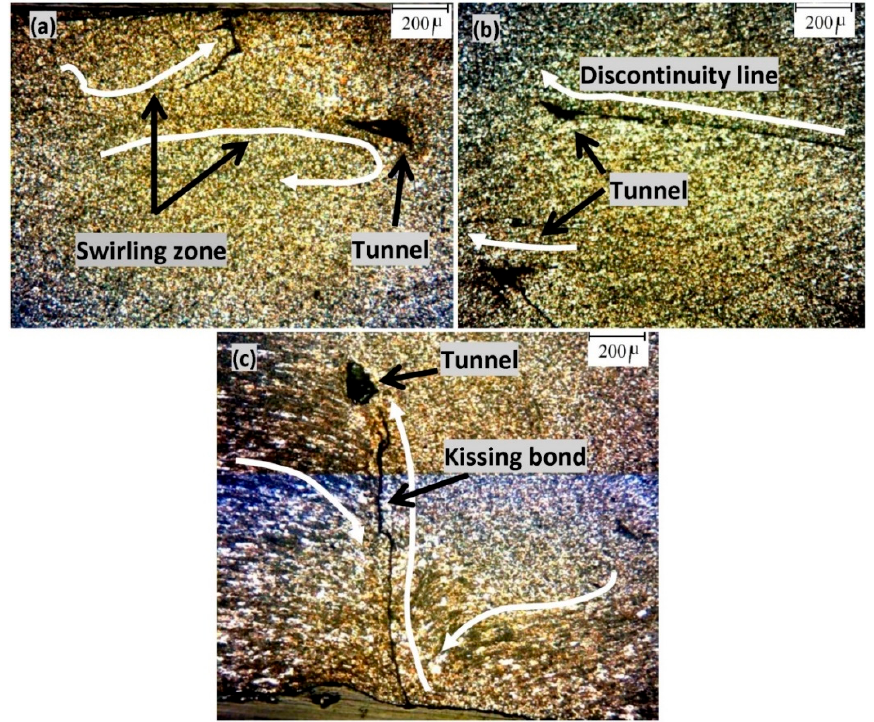
Figure 10. Formation of flow-based defects around tunnel voids formed by different FSW tools at constant speed sets of (250 mm/min and 1400 rpm); ( a ) conical pin profile, ( b ) square pin profile and ( c ) threaded pin profile.